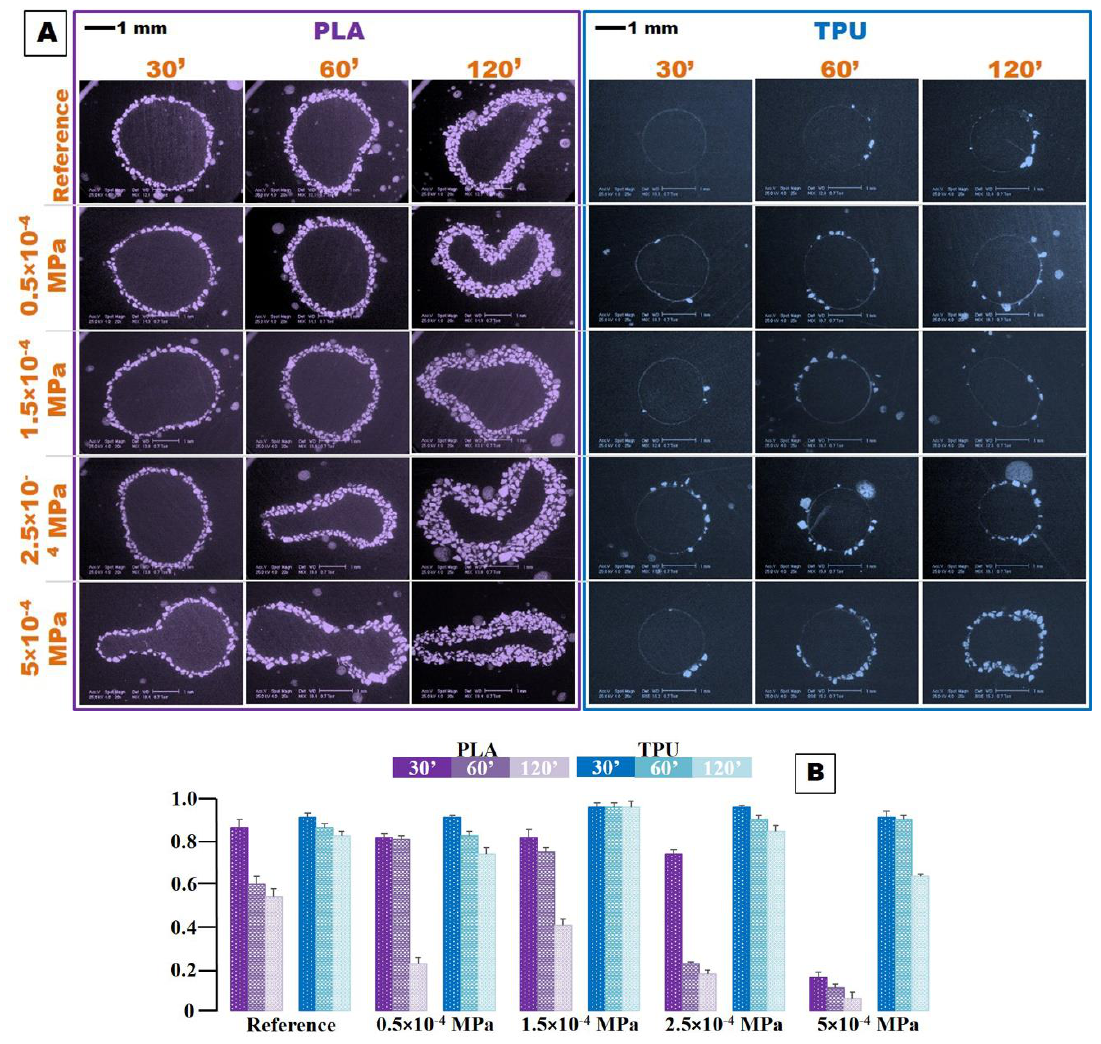
Figure 6. Form factor variation at 205 °C temperature . ( A ) Section morphology; ( B ) variation graphs.